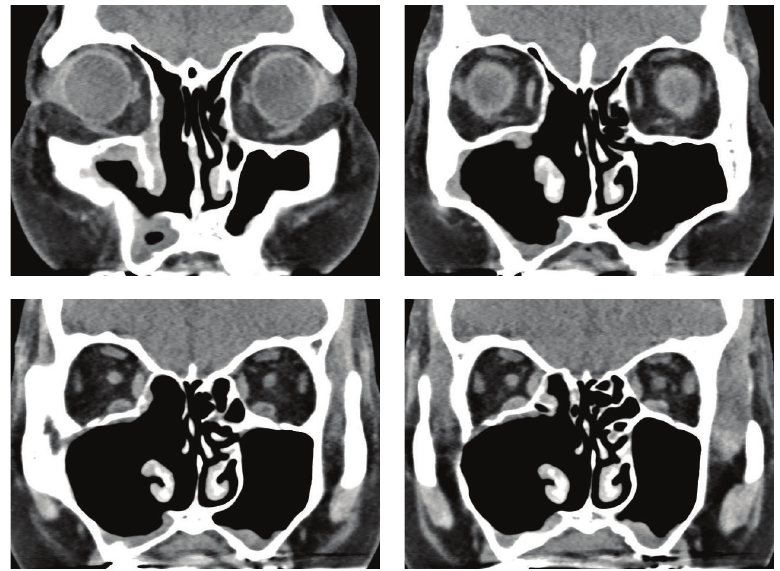
Figure 4: Postoperative CT observation. Granulation-like mucosal edema remained, but the maxillary sinus was widely opened from the middle and inferior meatus sides. The inferior turbinate was preserved.